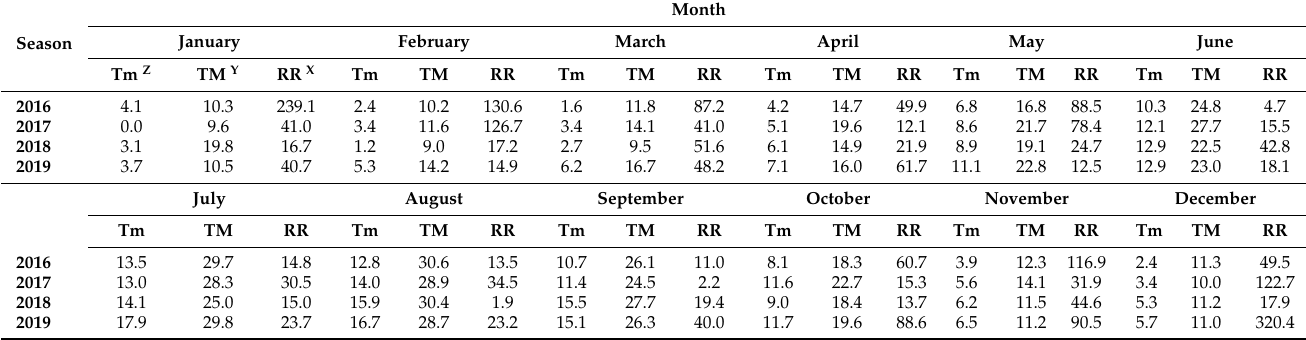
Table 1. Climatic conditions for the different seasons (2016, 2017, 2018, and 2019) in the district of Vila Real (https://tcktcktck.org/; accessed on 17 August